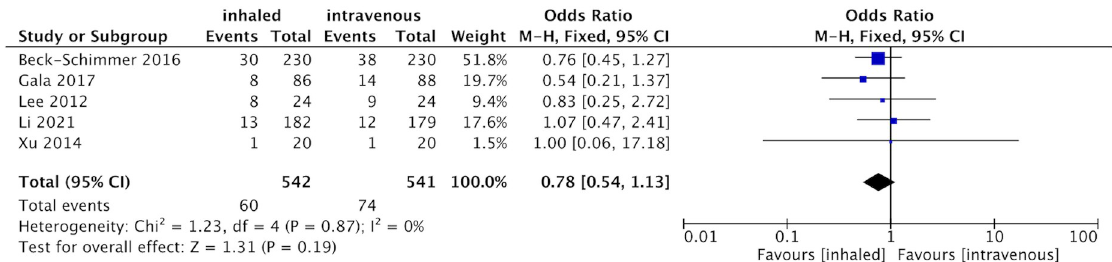
Fig 3. Forest plot for the number of the major postoperative complications between inhaled and propofol groups.